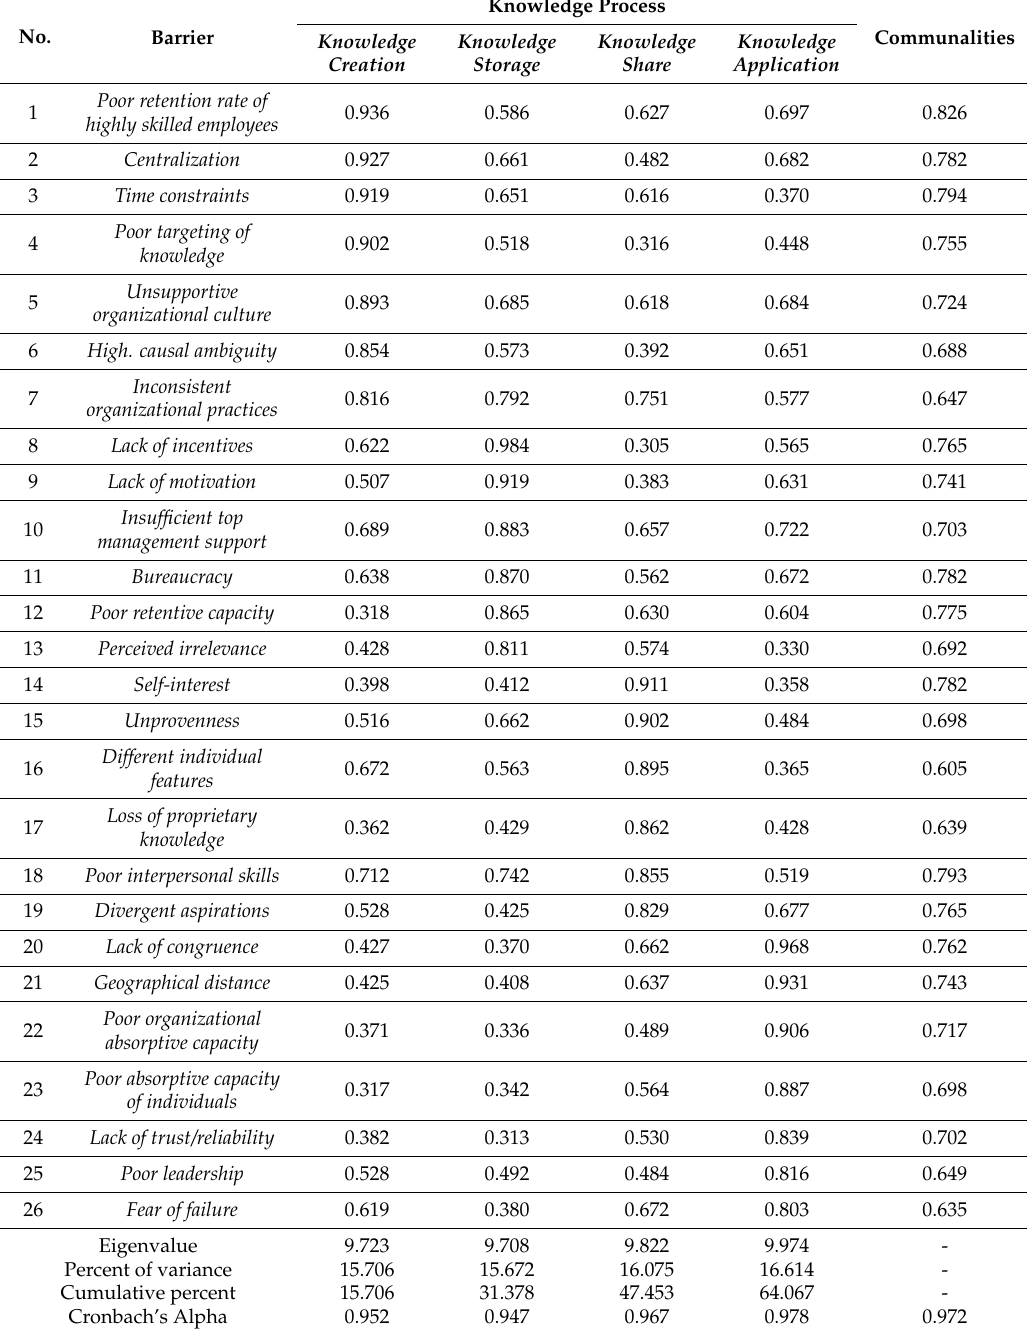
Table 3. Rotated Factor